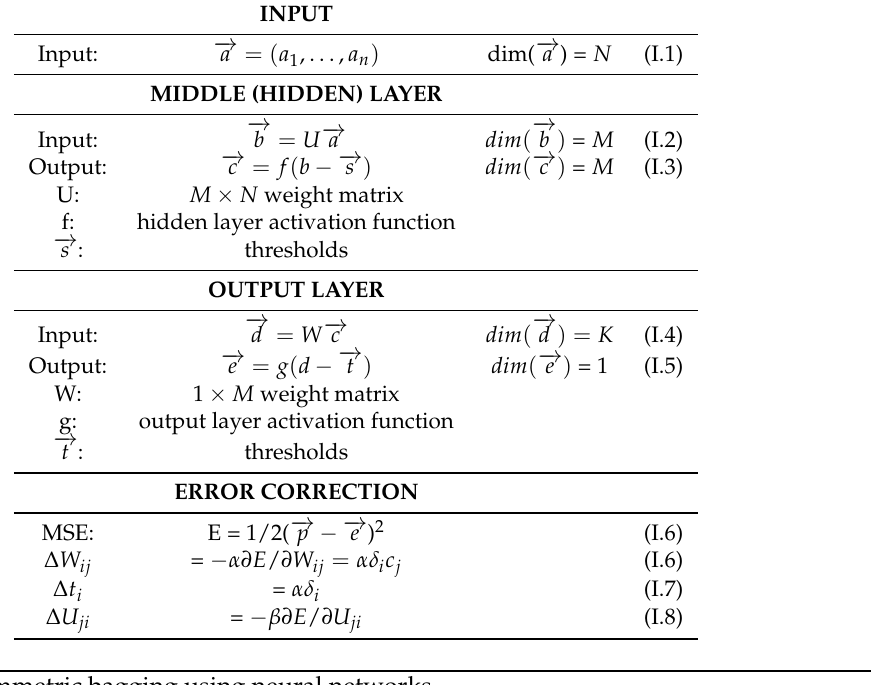
Algorithm 4 Asymmetric bagging using neural